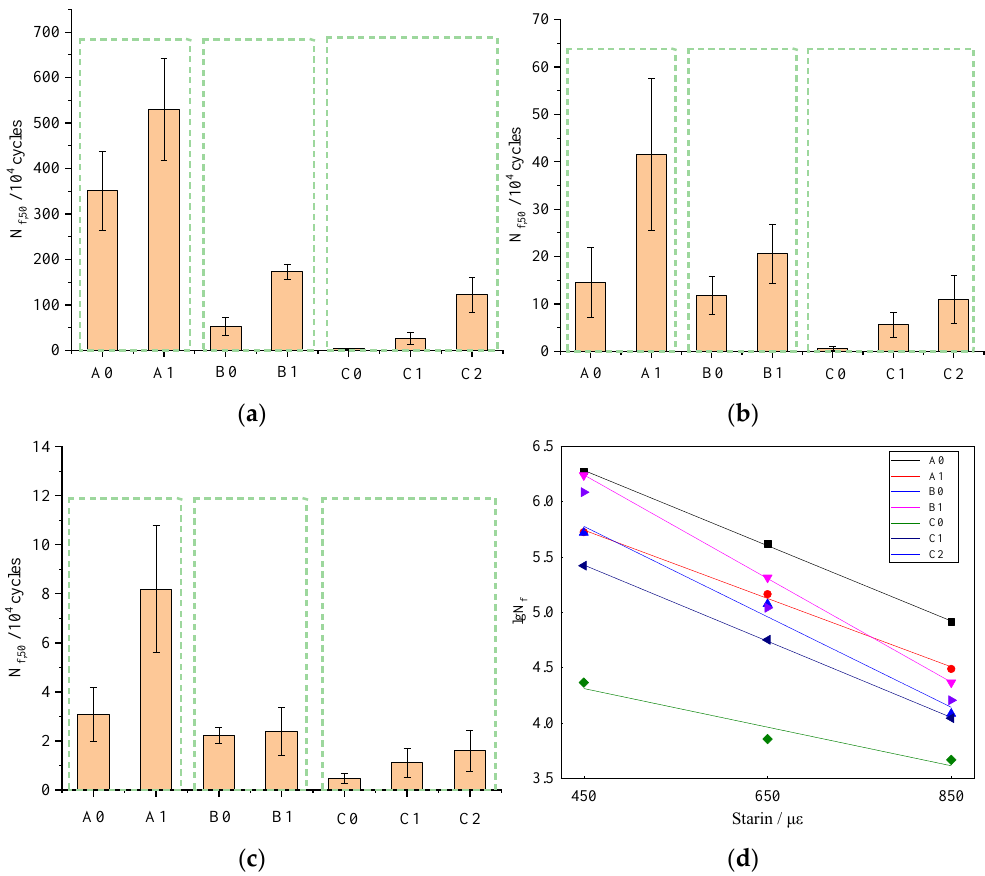
Figure 5. Fatigue test results: ( a ) 450 με , ( b ) 650 με , ( c ) 850 με and ( d ) relationship between fatigue life and strain. Table 5. Semilog fatigue equation of different asphalt mixtures.